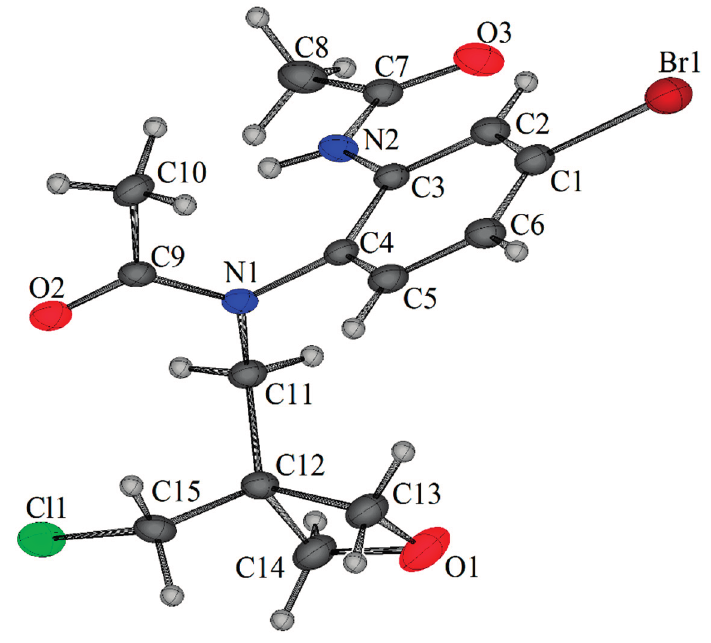
Figure 2. X-ray crystal structure of N -(2-acetamido-4-bromophenyl)- N -{[3-(chloromethyl) oxetan-3-yl]methyl}acetamide ( 9a )